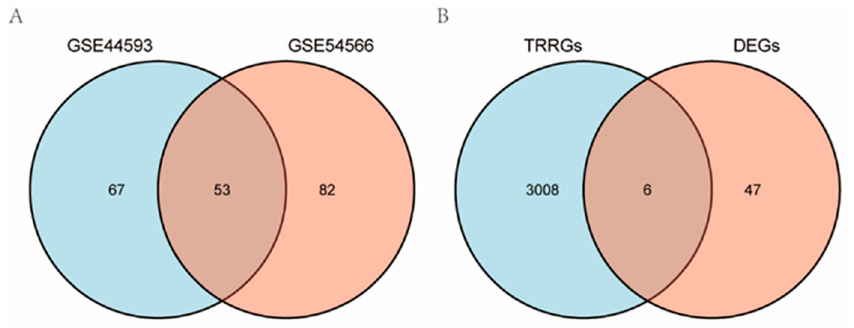
Figure 3. Venn diagrams displaying the overlap between significant DEGs and TR-related genes. ( A ) Common genes in GSE44593 and GSE54566. ( B ) TRRDEGs were analyzed by developing Venn diagrams of DEGs. Common genes in DEGs and the significant differentially expressed TR-related genes were analyzed by developing Venn diagrams of TRRDEGs.